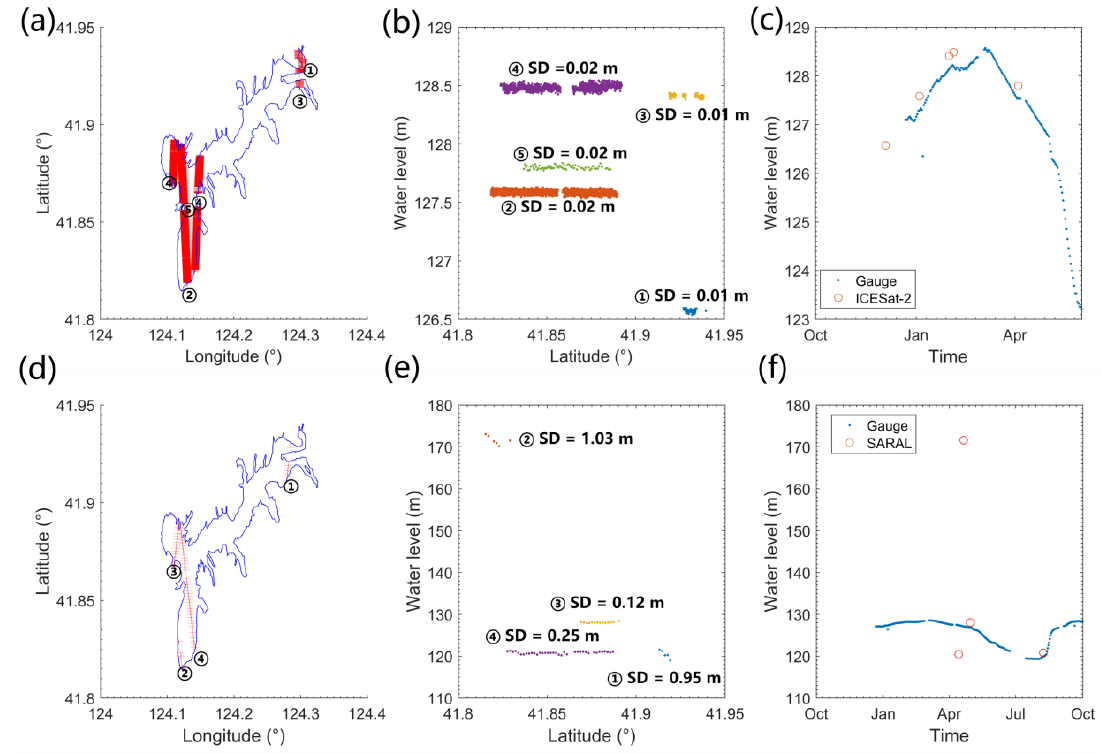
Figure 4. Example of water-level extraction at Dahuofang Reservoir by the ICESat-2 and SARAL data. ( a – c ) show the water level results of ICESat-2. ( d – f ) show the water level results of SARAL. For ( a ) and ( d ), the location of altimeter footprints (red cross) and the observation number are indicated. For ( b ) and ( e ), the estimated water levels along-track and the standard deviation of each observation time (SD) are indicated. For ( c ) and ( f ), the validation result, the gauge water level and altimetric water level are shown.